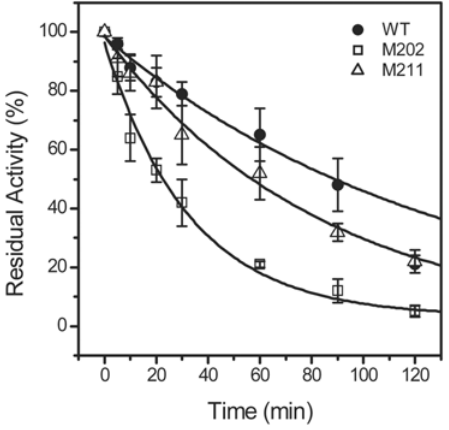
Figure 3. Thermal inactivation of the WT TcSOD, M202 and M211. The enzymes were dissolved in 20 mM phosphate buffer, pH 7.4, and heated at 95 ° C. Aliquots of the enzyme solutions were taken at given time intervals, and then the residual activity was measured by the pyrogallol method at 25 ° C. The final protein concentration was 0.27 mg/mL. The residual activity was normalized by taken the activity of the enzyme without heat-treatment as 100%. The data were fitted by the first-order kinetics, and the fitted data are presented as solid